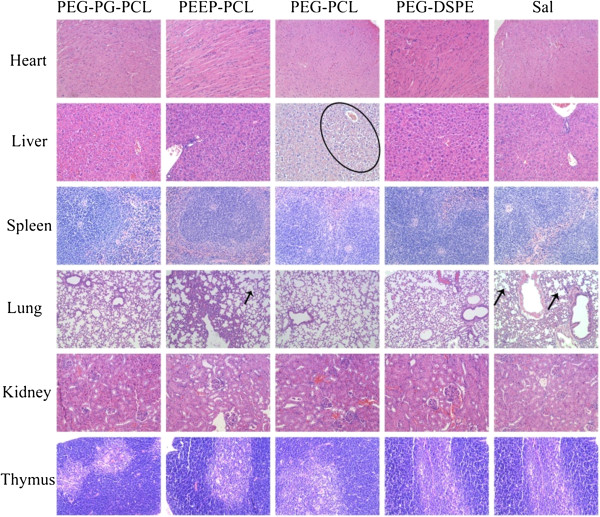
Histological observations of mice injected with different micelles. Saline-treated mice served as controls. The lung was observed under 200× magnifications, and other samples were observed under 400× magnifications. Black arrows indicate widened alveolar septum. The black circle indicates widened cytoplasm, lightly stained and highly loose areas in liver.